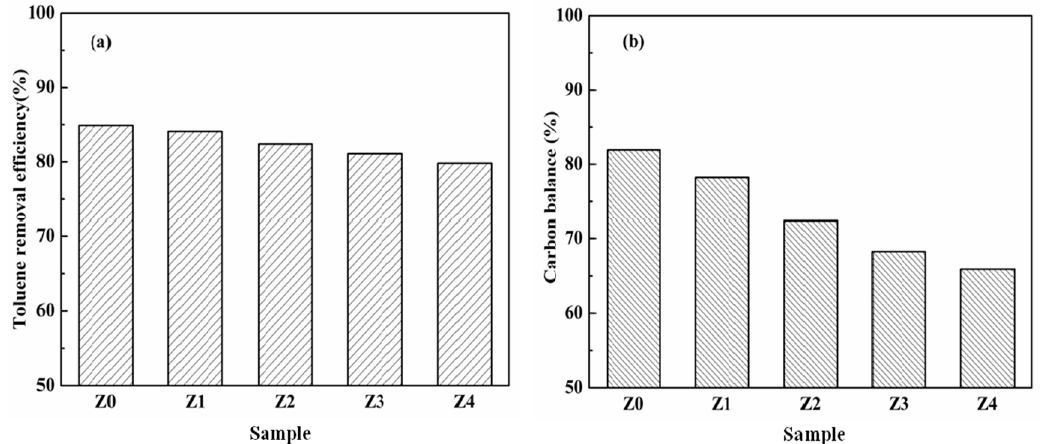
Figure 6. ( a ) Toluene removal efficiency and ( b ) carbon balance of the as-prepared catalysts.